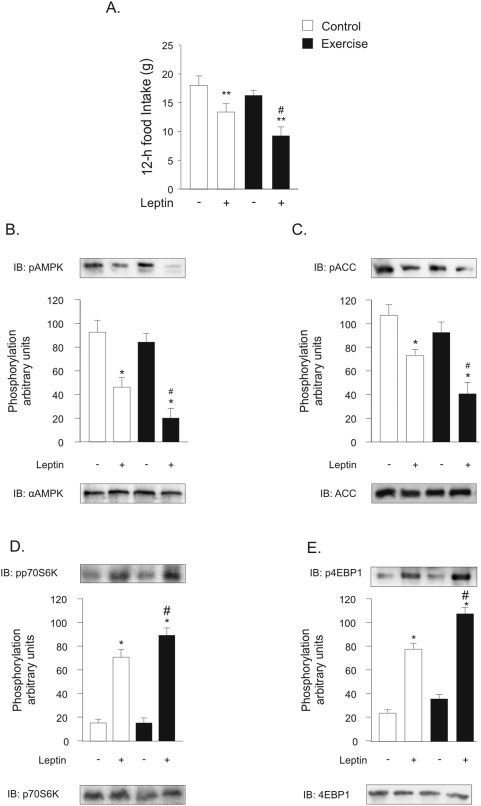
Leptin effects on 12-h cumulative food intake and AMPK/mTOR signaling, in the hypothalami of control and exercised rats.(a) Leptin (10−6 M) was administered in control and exercised rats. Animals were immediately exposed to food for a 12-hour period (n = 12–15 animals per group). (b, c, d, e) Representative Western blots of five independent experiments showing hypothalamic lysates from Wistar rats. Phospho-AMPKthr172, threonine-phosphorylated AMPK and total AMPK (b); phospho-ACCser79, serine phosphorylated ACC and total ACC (c); phospho-p70S6Kinasethr389, threonine phosphorylated p70S6Kinase and total p70S6K (d); phospho-4EBP1thr70, threonine phosphorylated 4EBP1 and total 4EBP1 (e). Data are the means±SEM. * p<0.05, ** p<0.01, vs. control group; # p<0.05, ## p<0.01 vs. leptin-stimulated control group.